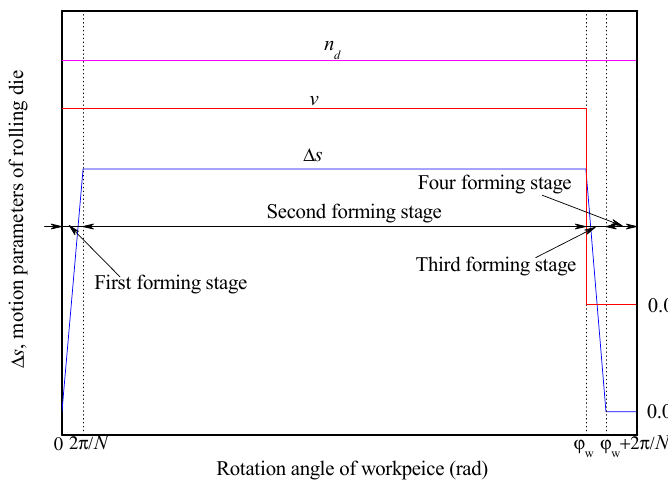
Figure 4. Forming stages divided according to compression amounts.